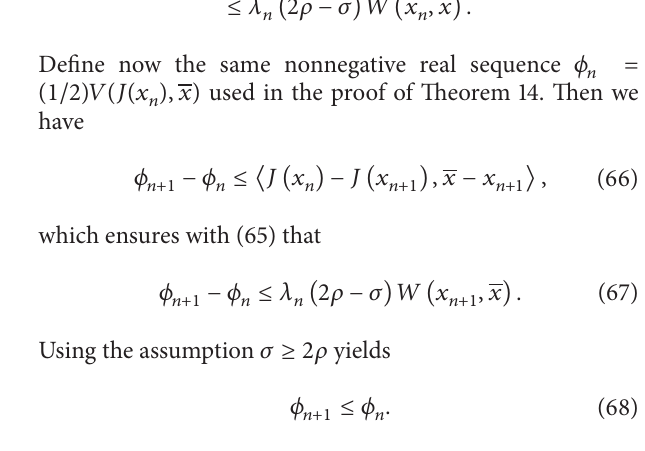
Algorithm 17. Let 𝛿 𝑛 ↓ 0 with 𝛿 0 be too